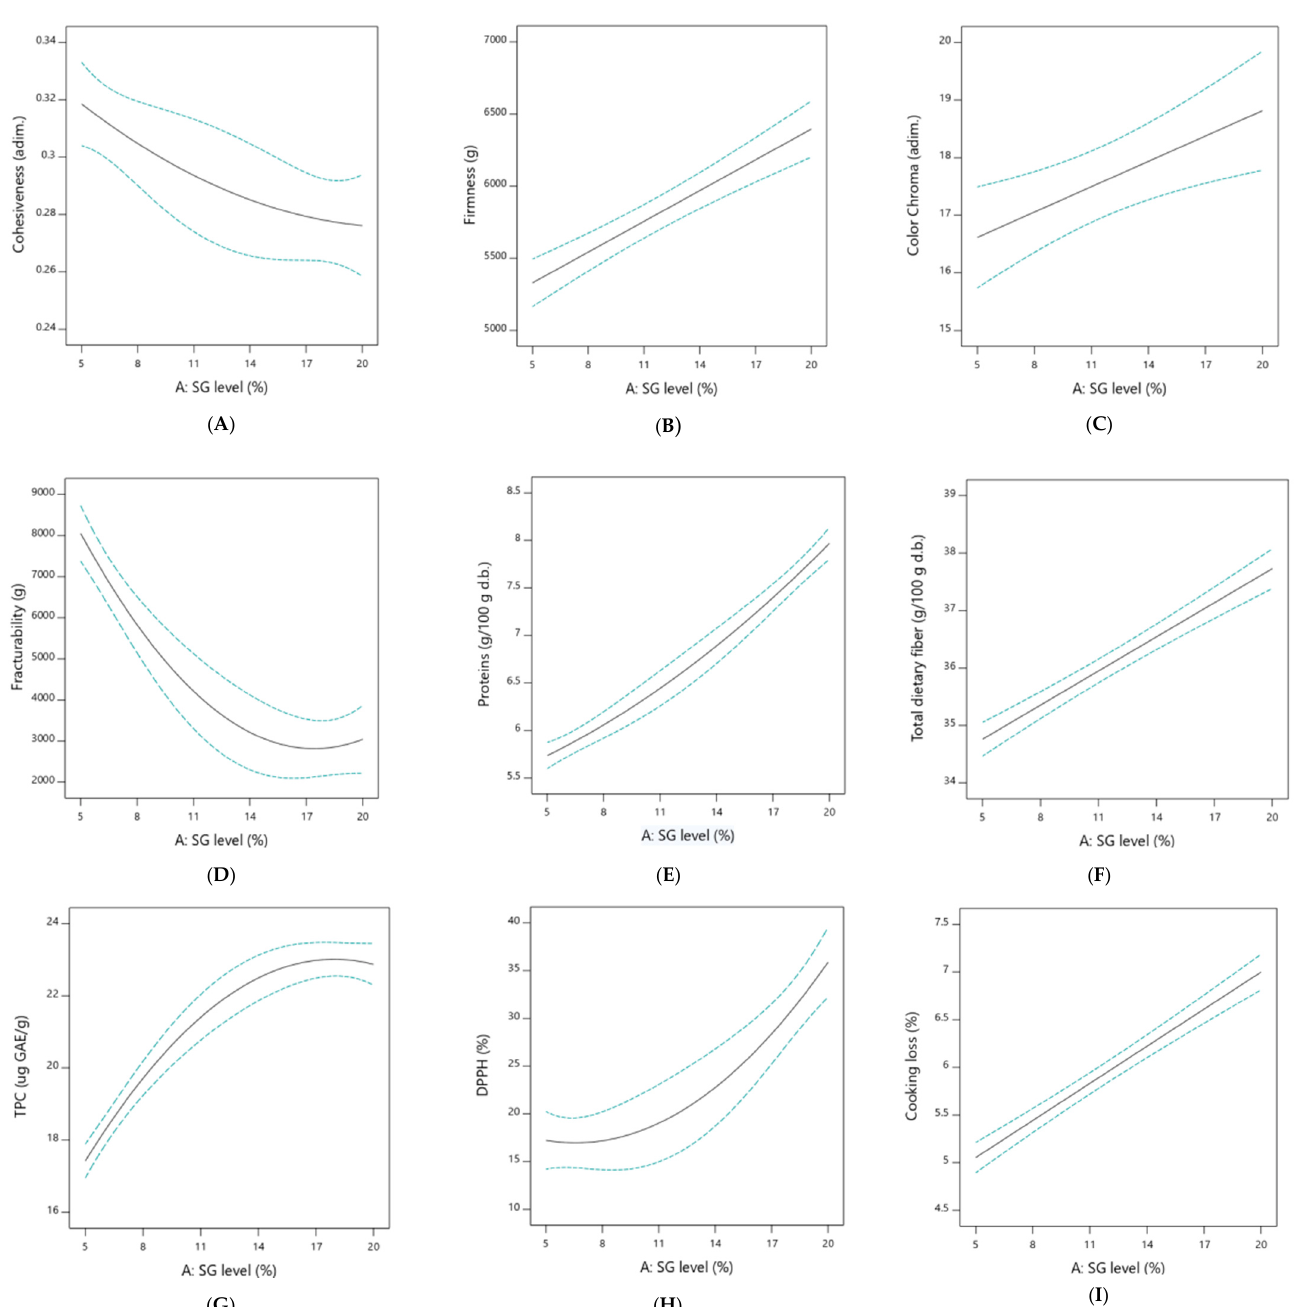
Figure 1. Effect of spent grain on ( A ) dough cohesiveness, ( B ) firmness of pasta dough, ( C ) pasta color, ( D ) pasta fracturability, ( E ) protein content, ( F ) total dietary fiber content, ( G ) total phenolic content, ( H ) antioxidant activity of pasta, and ( I ) pasta cooking loss.